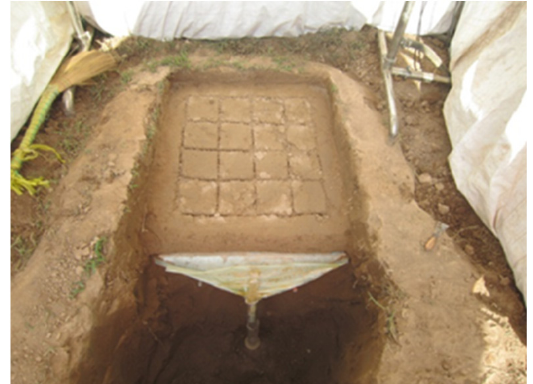
Figure 2. Diagram of S2 experimental setup.